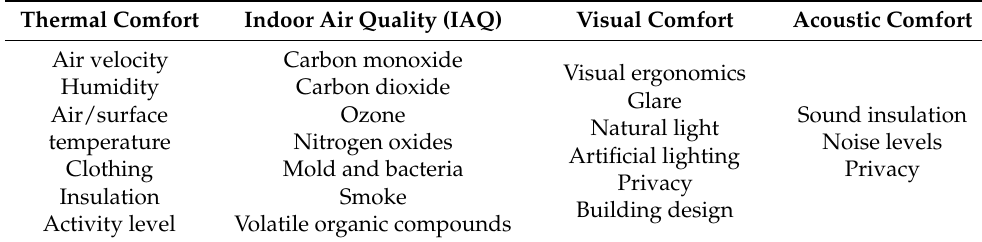
Table 1. Components of indoor environmental